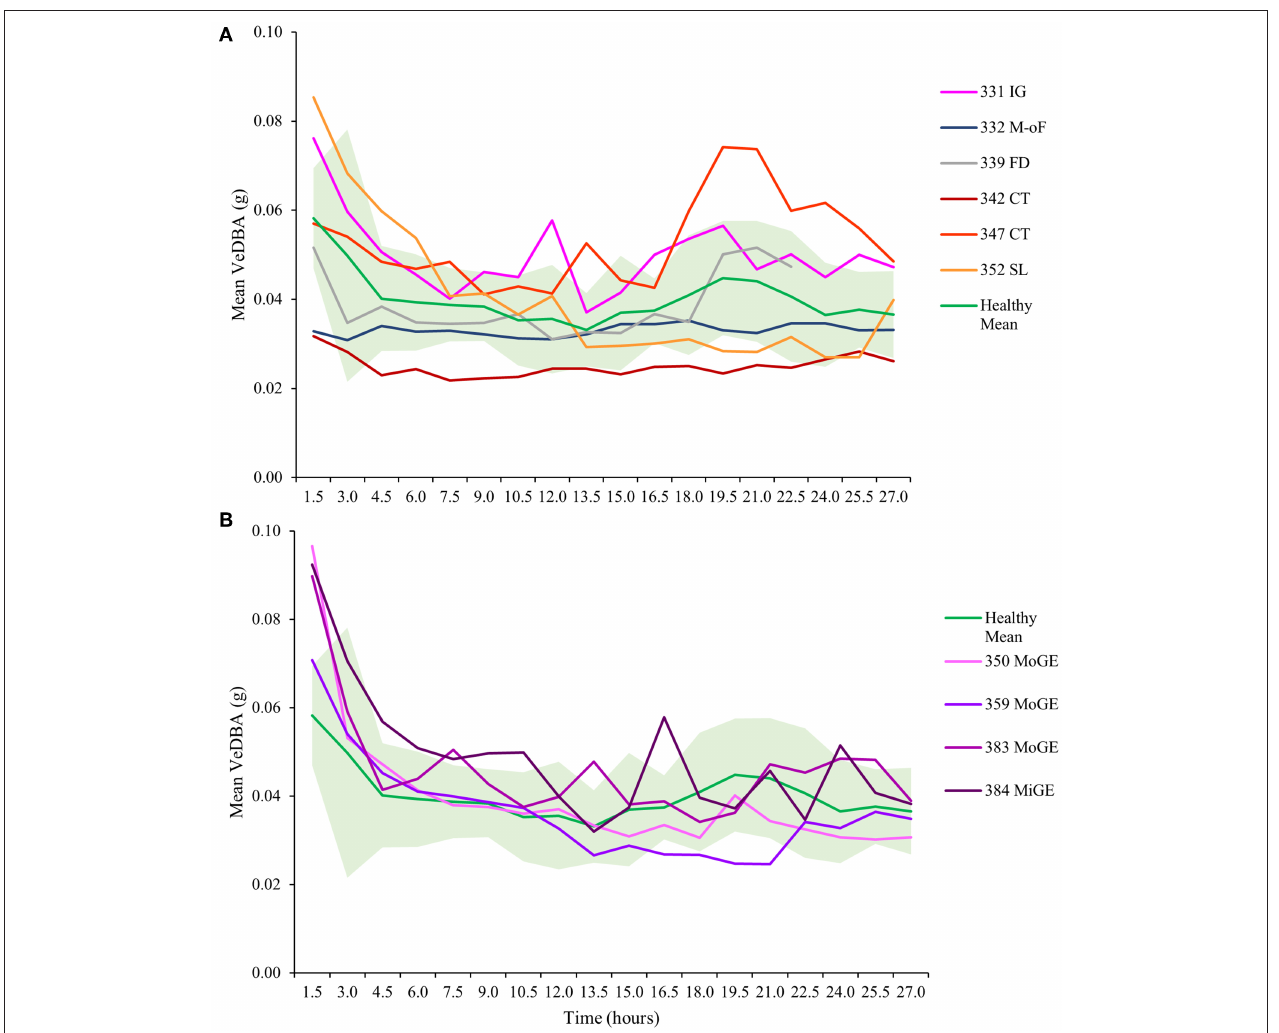
FIGURE 4 | Mean VeDBA (calculated over hourly intervals) in turtles with (A) various diseases and injuries and (B) turtles with gas emboli (GE), from the first moment they were tagged (cf. Figures 2 , 3 ). Turtles are identified by number (see Table 1 ). IG, intestinal gas; M-oF, multi-organ failure; FD, flipper damage; CT, carapace trauma; SL, skin lesions; MoGE, moderate gas emboli; MiGE, mild gas emboli. The mean VeDBA of turtles that were considered healthy upon entry (individuals T324, T325, T330, T344, T345, T385, and T396) is shown in green; the shaded light green area represents one standard deviation. Note the initially high values observed